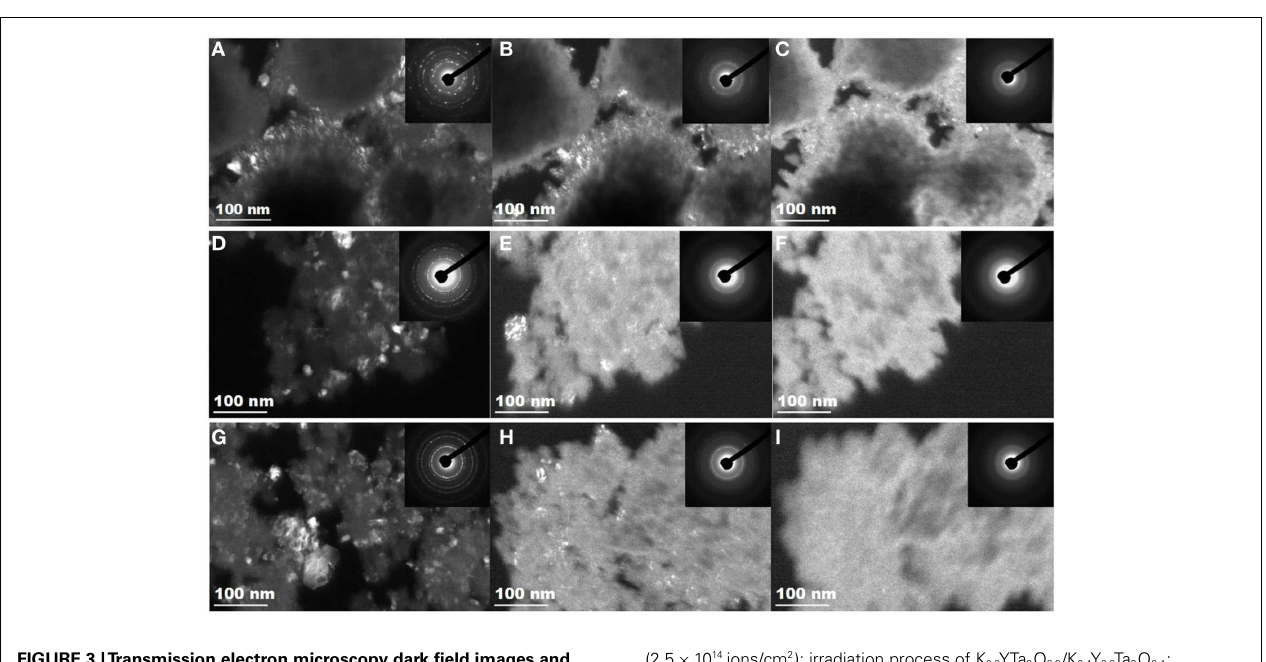
(2.5 × 10 14 ions/cm 2 ); irradiation process of K 0.8 YTa 2 O 6.9 /K 0.4 Y 0.8 Ta 2 O 6.4 : (D) unirradiated, (E) 0.05dpa (1 × 10 14 ions/cm 2 ), (F) amorphized at